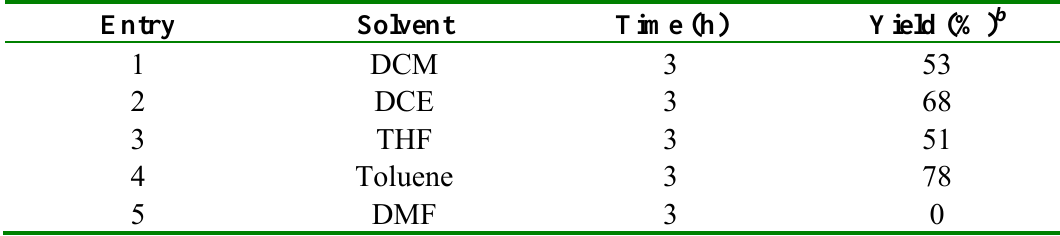
Table 2. Effect of the solvent on the yields . a